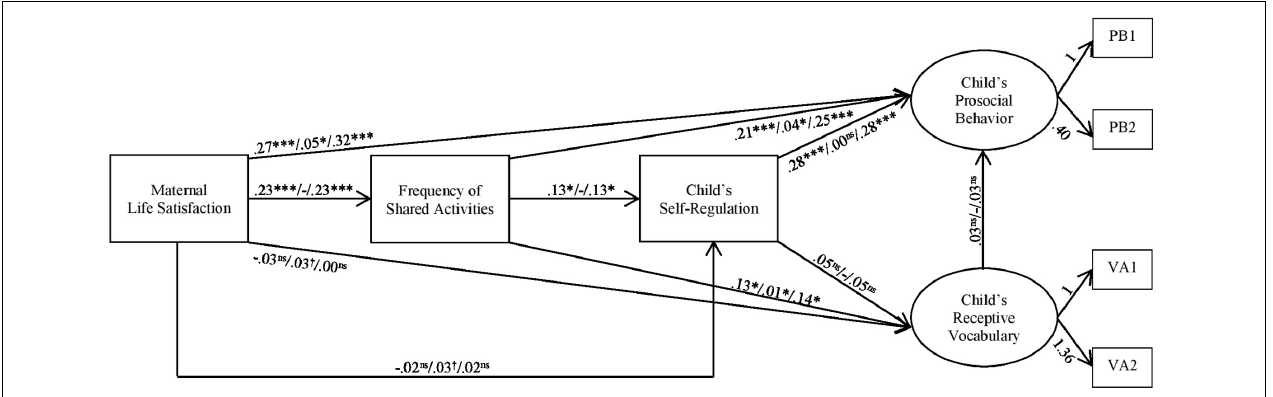
FIGURE 3 | Structural model predicting the latent factors prosocial behavior and receptive vocabulary from the manifest variables self-regulation, frequency of shared parent-child activities, and maternal life satisfaction. All equations are controlled for child’s age and sex. selective equations are controlled for child’s liking for gummi bears and having siblings (Hlb, H2a). visiting day-care/school (H1d, H2c, H3b), mothers verbal abilities (HIa, H1d, H2c, H3b) and mother’s education (Hla, Hlc, Hid, H2b, H2c, H3a, H3b). Printed path estimates are standardized β -coefficients in the following order: direct effect/indirect effect/total effect; † p < 0.1, ∗ p < 0.05 , ∗∗ p < 0.01, ∗∗∗ p < 0.001. N = 291 mother-child